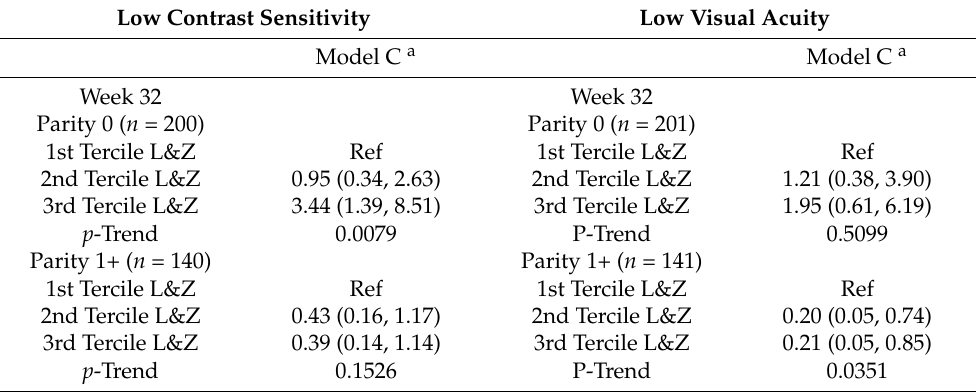
Table 4. Stratified multiple adjusted analysis by parity (nulliparous vs. multiparous) of the association between maternal lutein and zeaxanthin intake and low contrast sensitivity and visual acuity based on the lowest 20th centile cut off in the Sabadell cohort of the Spanish Childhood and Environment (INMA)